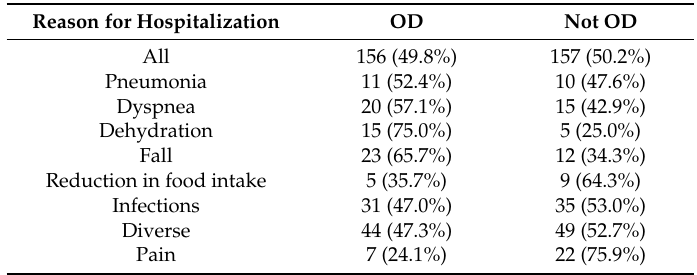
Table 2. Prevalence of oral dysphagia by reason for